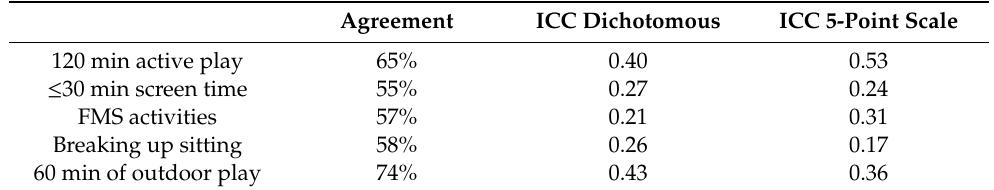
Table 3. Agreement and intraclass correlation (ICC) between managers and sta ff for dichotomous data.